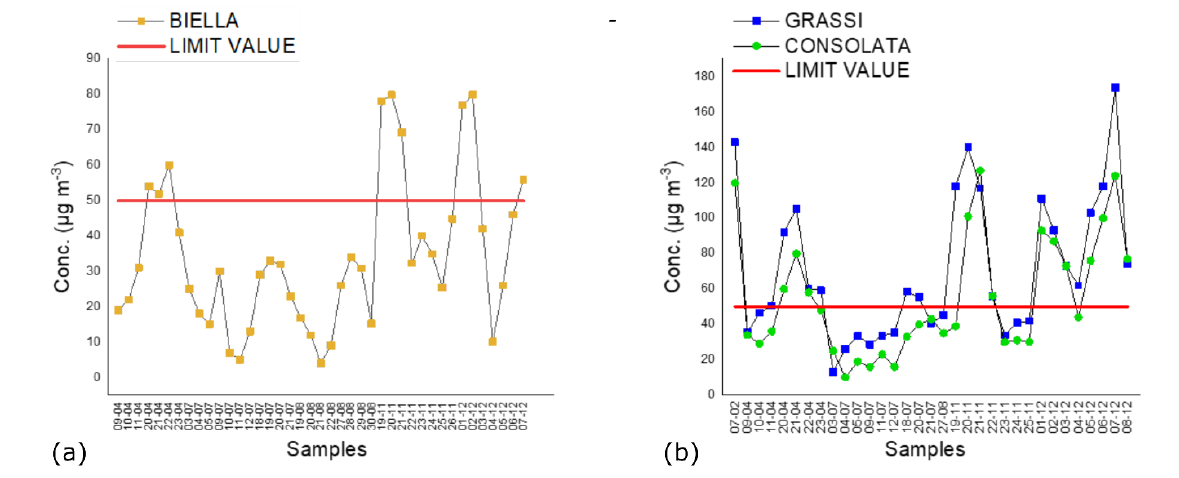
Figure 2. Concentrations of PM 10 samples expressed in µ g m − 3 for ( a ) Biella site and ( b ) sites of Turin (Grassi and Consolata). The red lines indicate the law limit of 50 µ g m − 3 . The lowest PM 10 concentrations are in July and August with values of 13 µ g m − 3 in G 03_07, 10 µ g m − 3 in C 05_07 and 4 µ g m − 3 in B 21_08.